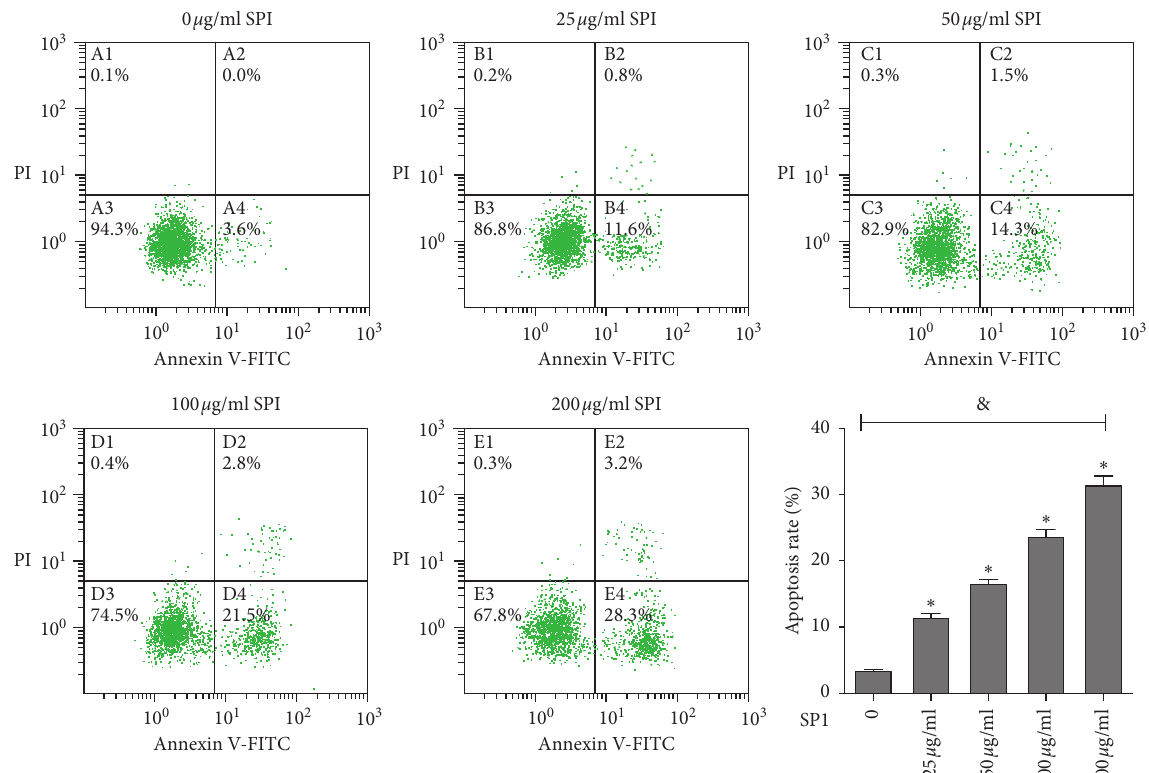
Figure 3: Apoptosis of MGC-803 cells treated with different concentrations of SP1 (0, 25, 50, 100, and 200 μ g/ml) for 72h was detected by flow cytometry. Compared with 0 μ g/ml SP1-treated (control) group, ∗ P < 0 . 05; & P < 0 . 05 for comparison between groups under different concentrations of SP1 treatment.